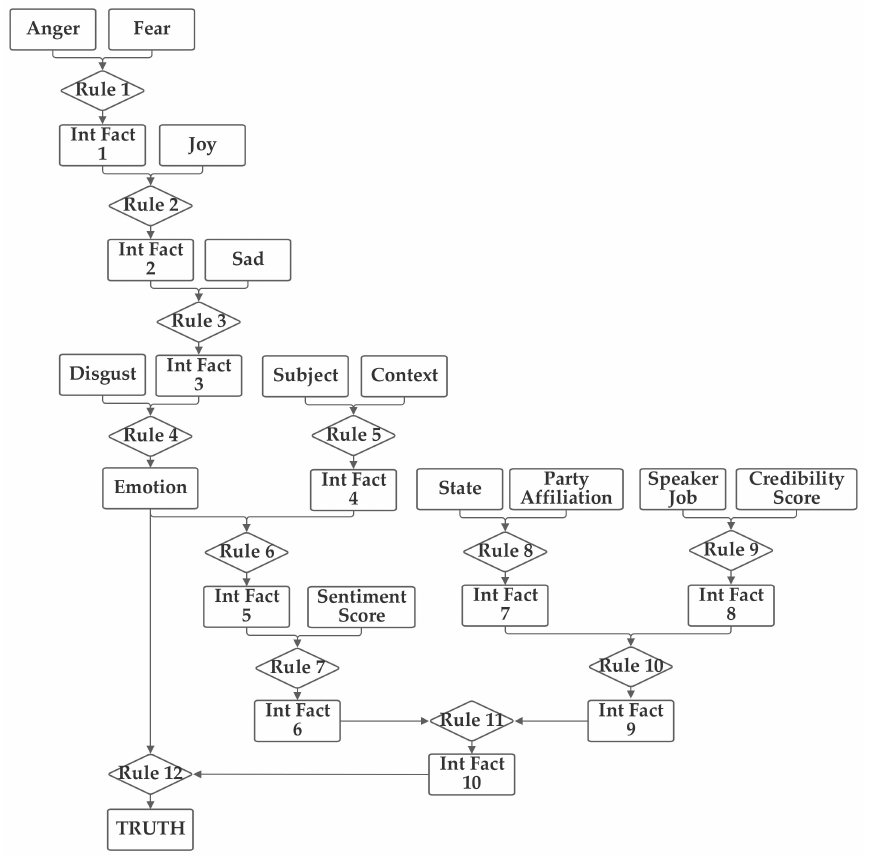
Figure 14. Depiction of Network